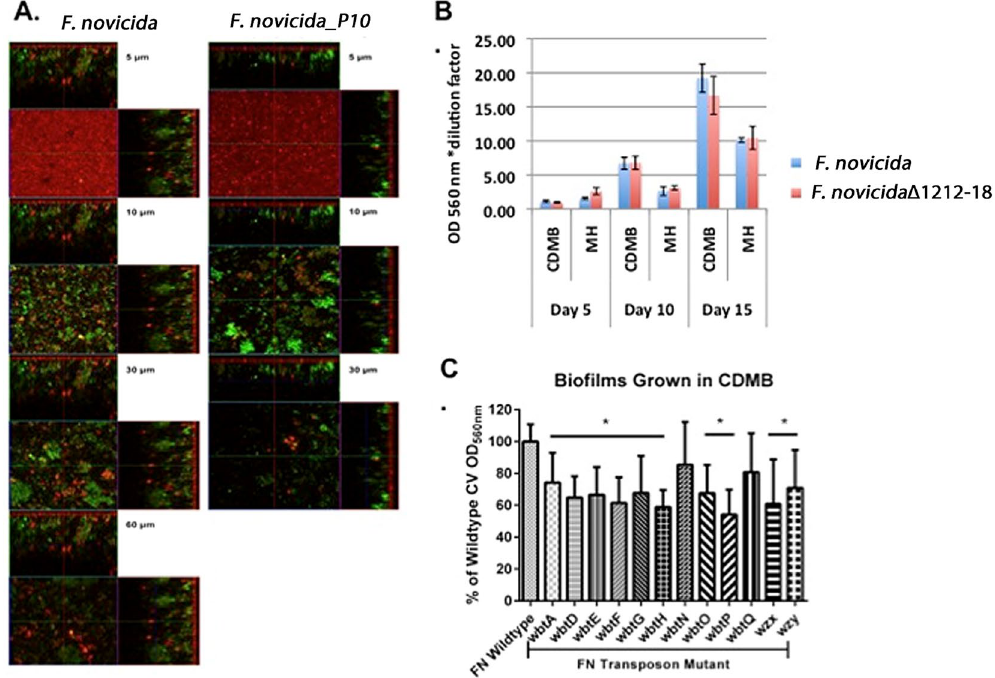
Figure 7. Comparison of biofilm development by F . novicida and mutant strains. ( A ) CLSM: Orthogonal sections of horizontal (z) and side views (x and y) of reconstructed three-dimensional biofilm images at a magnification of 25x. Nucleic acids were stained with Syto9 (green) and the matrix EPS was stained with Texas Red-Con A (red). Passage of F . novicida in CDMB to increase CLC production resulted in a less robust biofilm by day 10, but initial attachment did not appear to be affected. Large, dense aggregates of cells were evident by day 10. ( B ) Comparison of biofilm development by F . novicida and its CLC-deficient mutant grown in CDMB and MHB. No significant differences were seen between parent and mutant biofilms formed in either medium. Like Type B strains, biofilm development peaked at ~15 days. ( C ) Biofilm development of O-Ag mutants of F . novicida . F . novicida biofilms were grown for 5 days in CDMB and stained with CV. Data are shown as percent comparison to the parent F . novicida strain. All O-Ag mutants produced less biofilm than the parent except mutants in the wbtN and wbtQ